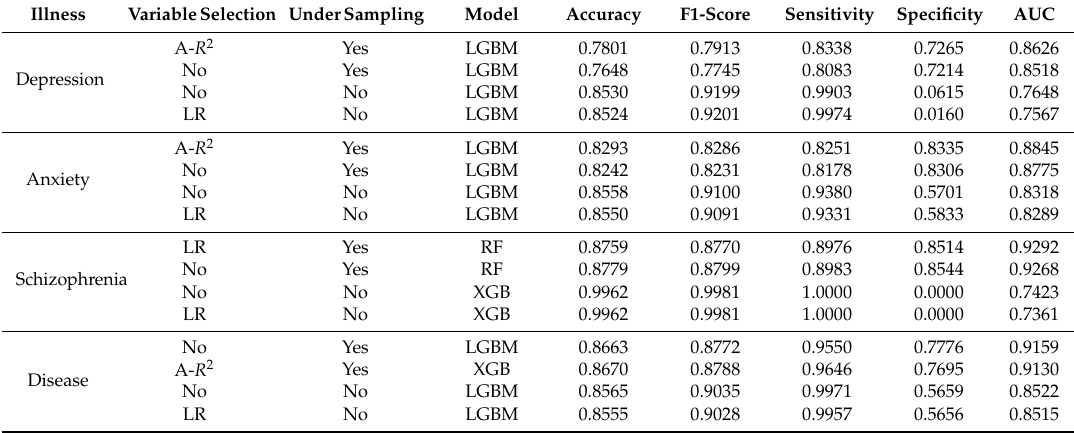
Table 7. Prediction performance of four di ff erent approaches for mental